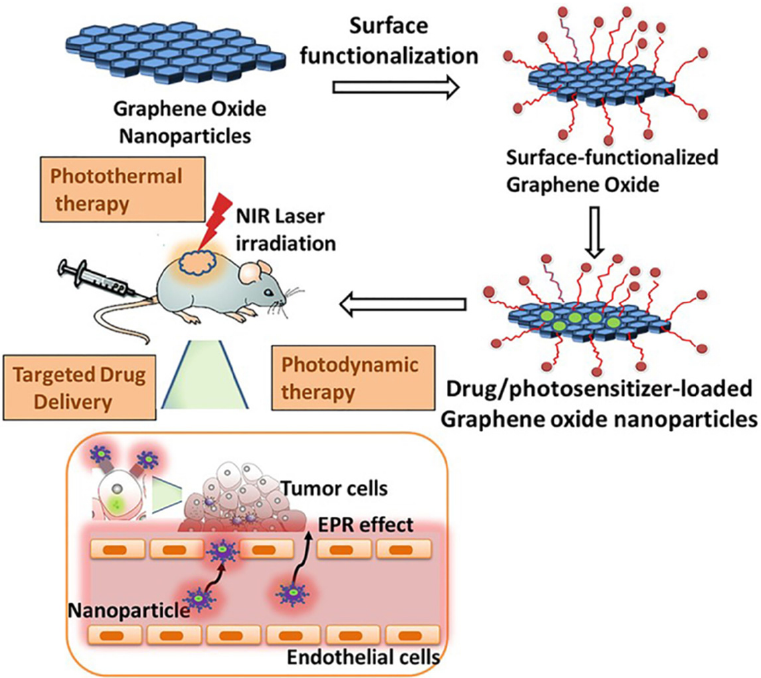
Figure 5. Procedure to apply GO-based hybrids/composites in PDT, PTT, and targeted drug delivery. EPR: enhanced permeability and retention. Reproduced from Ref. [58]. Copyright 2020 with permission from MDPI.